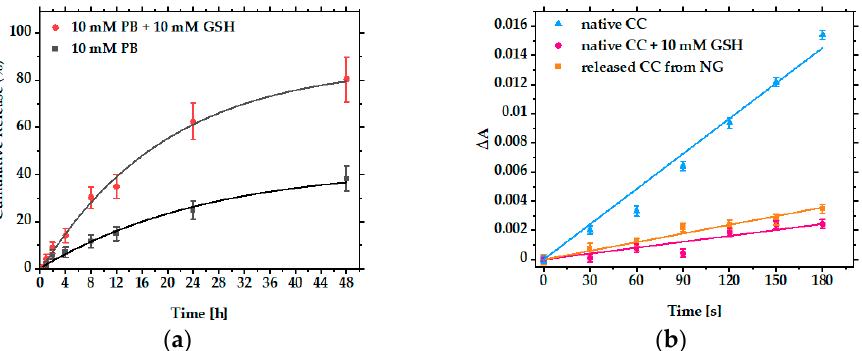
Figure 4. ( a ) Release of cytochrome C (CC) from loaded nanogels (NGs) with addition of L - glutathione (GSH) (blue) and control in buffer (black). The release was carried out at 37 °C in 10 mM phosphate buffer (PB) at pH 7.4. ( b ) Oxidative ABTS assay with native CC (blue), GSH-treated native CC (red), and CC released from NGs (orange).